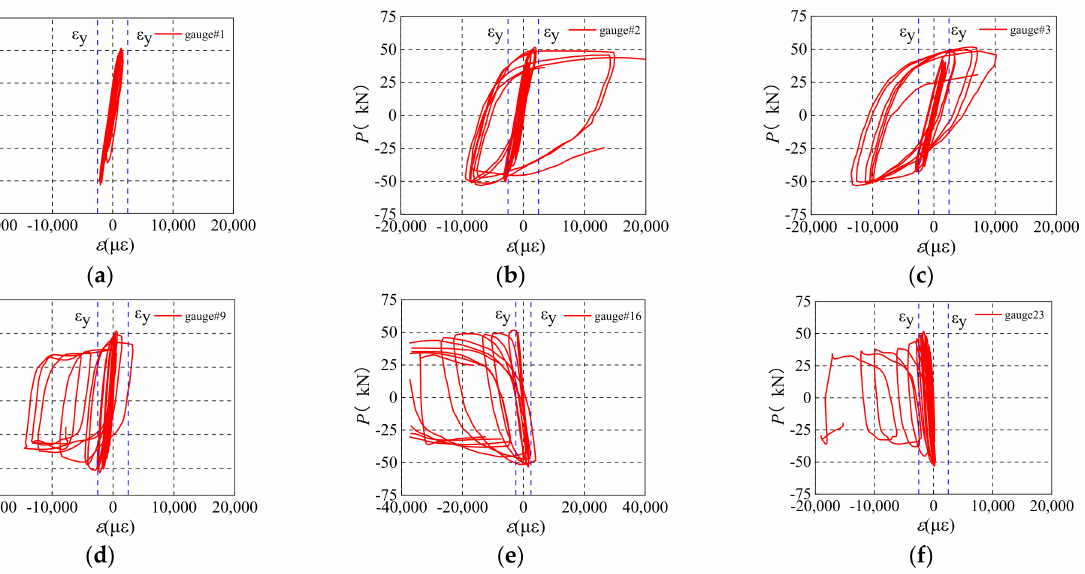
Figure 14. ( a ) P- ε y hysteresis curve for STG4-0.5-0.25 of gauge#1; ( b ) P- ε y hysteresis curve for STG4-0.5-0.25 of gauge#2; ( c ) P- ε y hysteresis curve for STG4-0.5-0.25 of gauge#3; ( d ) P- ε y hysteresis curve for STG4-0.5-0.25 of gauge#9; ( e ) P- ε y hysteresis curve for STG4-0.5-0.25 of gauge#16; ( f ) P- ε y hysteresis curve for STG4-0.5-0.25 of gauge#23.